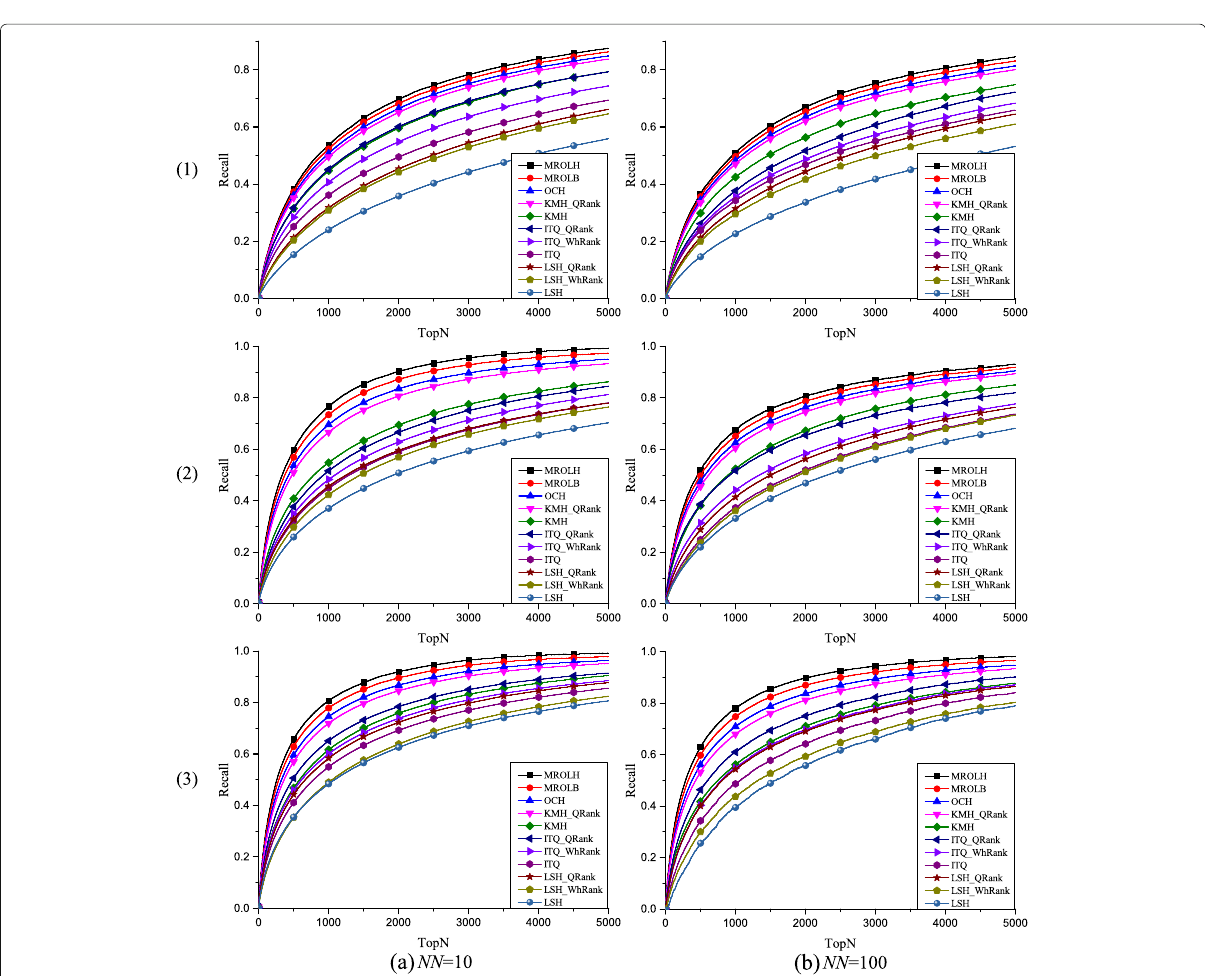
Fig. 3 The recall curves of the comparative experiments in the Cifar10 dataset. The data are separately mapped into 32-, 64-, and 128- bit binary codes in the (1), (2), and (3) rows. The number of the true nearest neighbors in columns a and b separately are 10 and